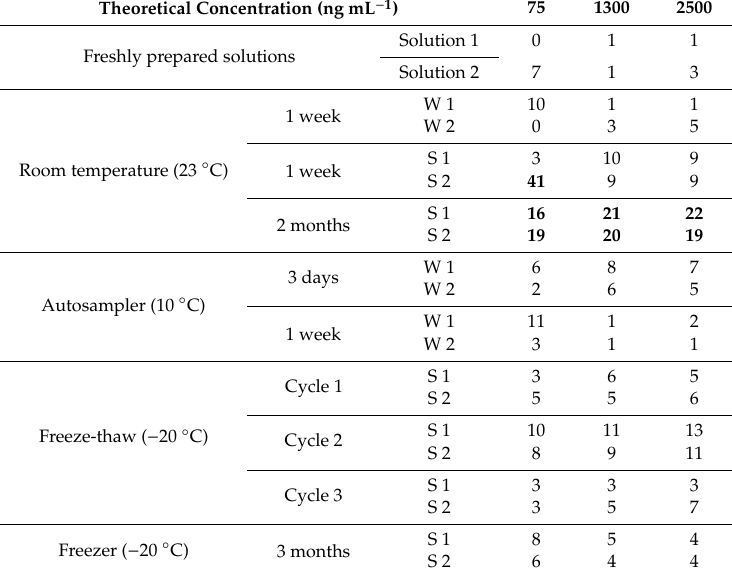
Table 5. β -ODAP stability determined as accuracy and expressed as %, for β -ODAP stock solution (S) and working solutions (W). TC—Theoretical Concentration, expressed as ng mL − 1 . Values in bold: accuracy > 15%.